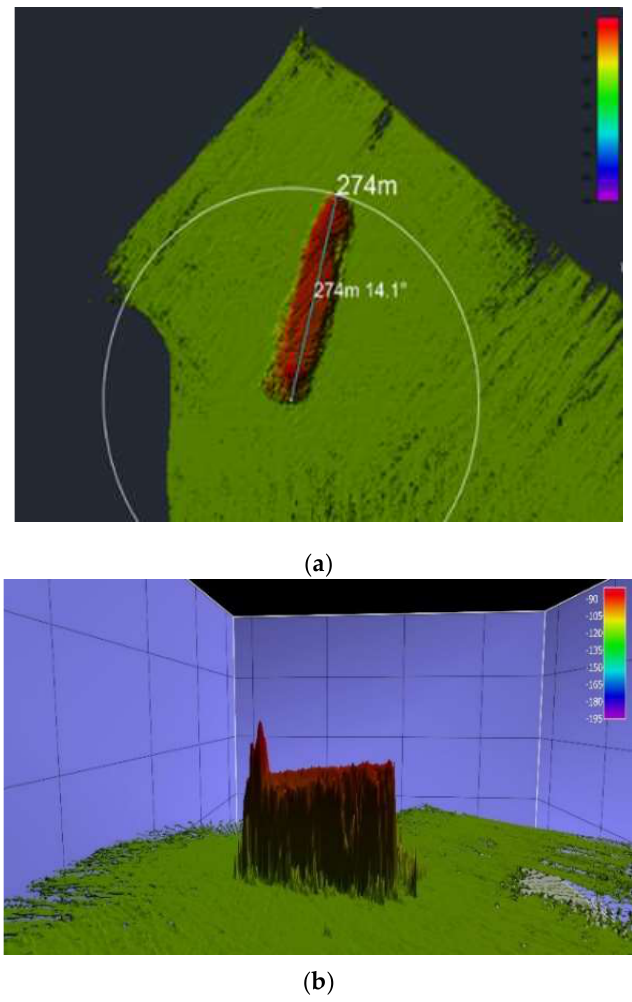
Figure 18. ‘Sanchi’ multibeam view: ( a ) Shipwreck front view, ( b ) shipwreck side view.